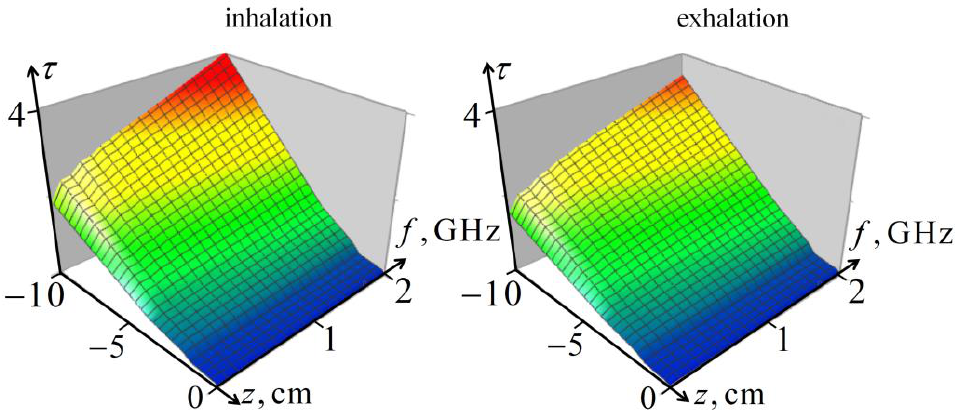
Figure 2. Frequency-depth distribution of the optical thickness τ in five-layered tissues of the thorax. The numerical simulation of the cover structure retrieval